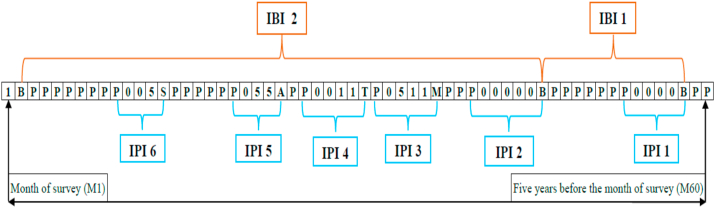
Pictorial representation of IPI.P – pregnant, B – Birth, S – Still birth, A – Abortion, T – Termination, M – Miscarriage, 0 – not using any contraception, 1– using pill, 5 – using condom.Note: One box represents one month.